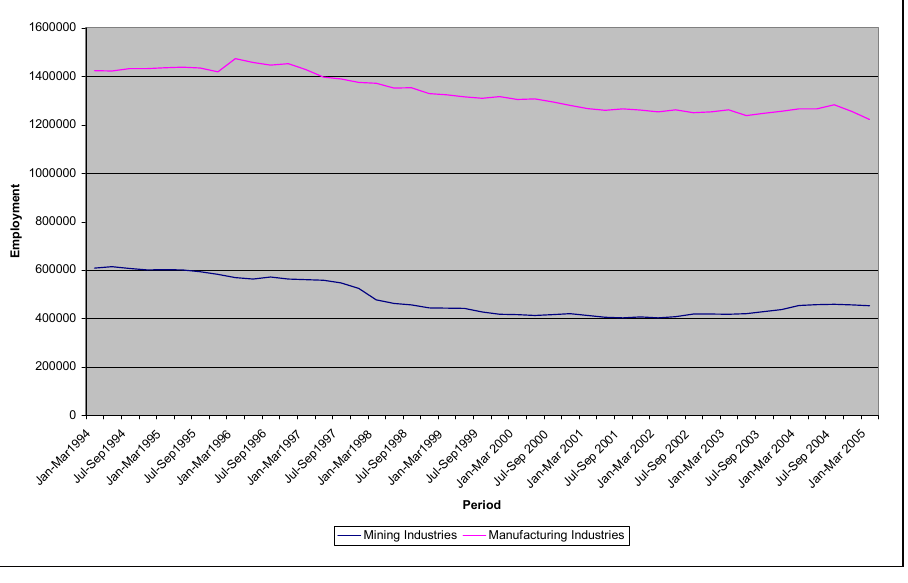
Figure 1 Graphic representation of employment figures in the mining and manufacturing industries between 1994 and 2005